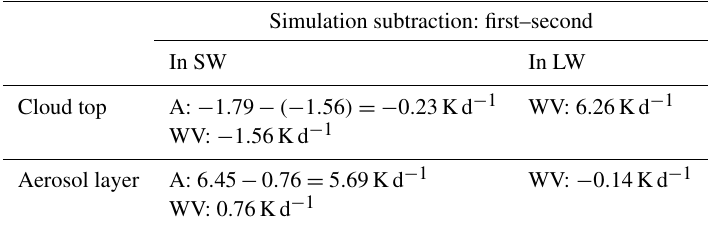
Table 4. Subtraction of aerosol (A) and water vapour (WV) contributions in shortwave (SW) and longwave (LW) ranges between the first and second